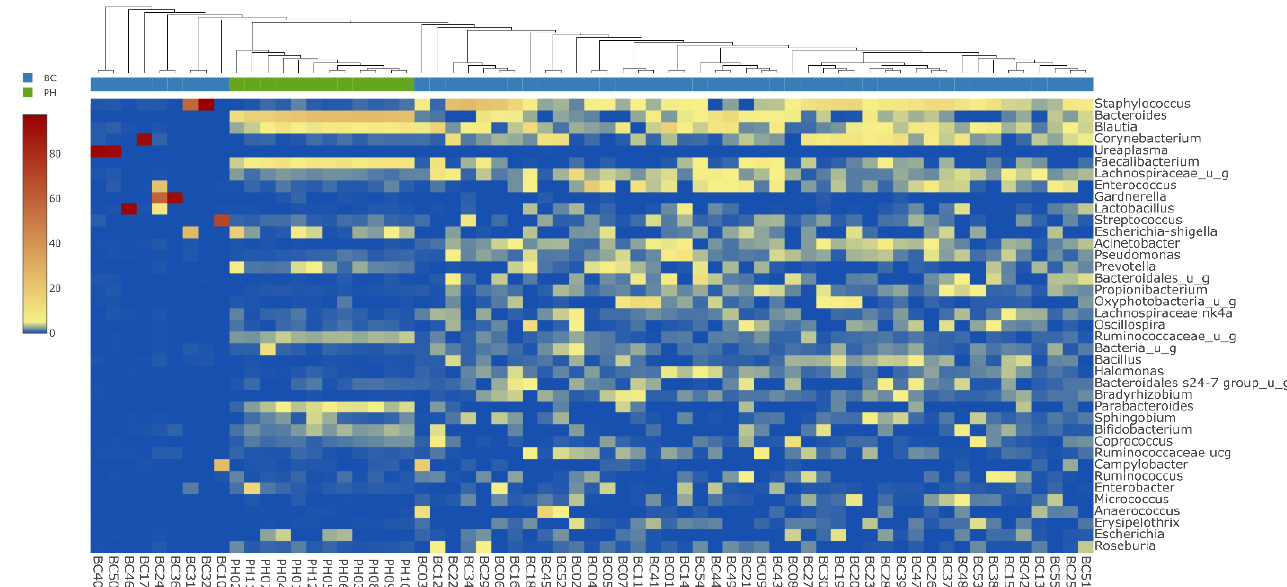
Figure 2. Heatmap visualization of the most abundant taxa at genus level among the BC and PH patients. The samples of the PH and BC groups are sharply separated; additionally, 9 samples of the BC group were detached in which some specific genera showed a remarkably high presence .